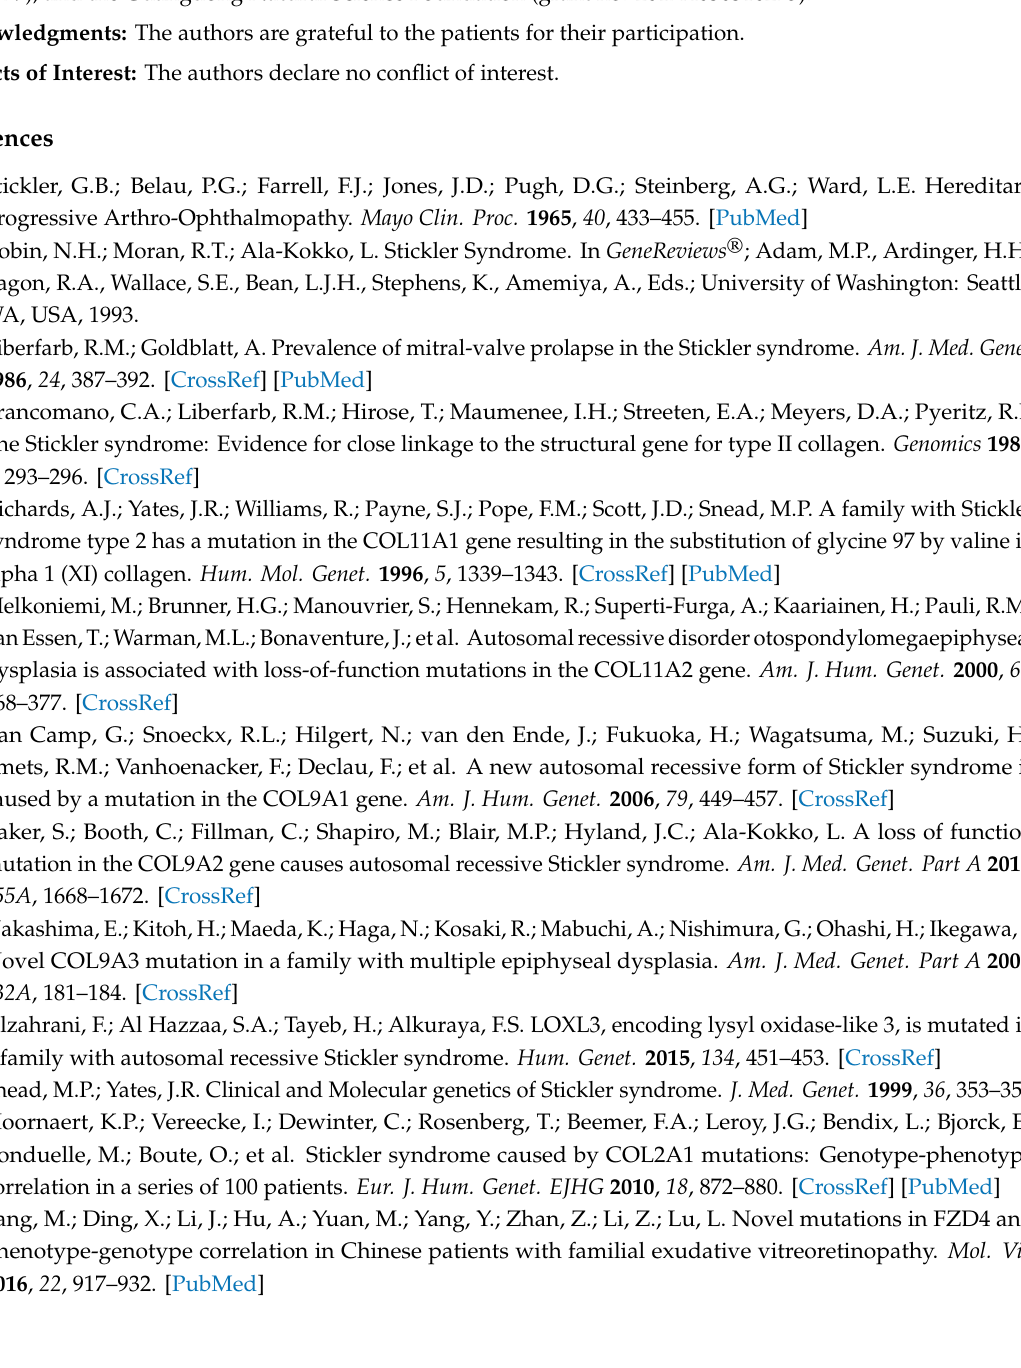
Figure S1: Vitreous changes or retinal abnormalities from Scanning laser ophthalmoscopy (SLO), Table S1: Diagnose of the